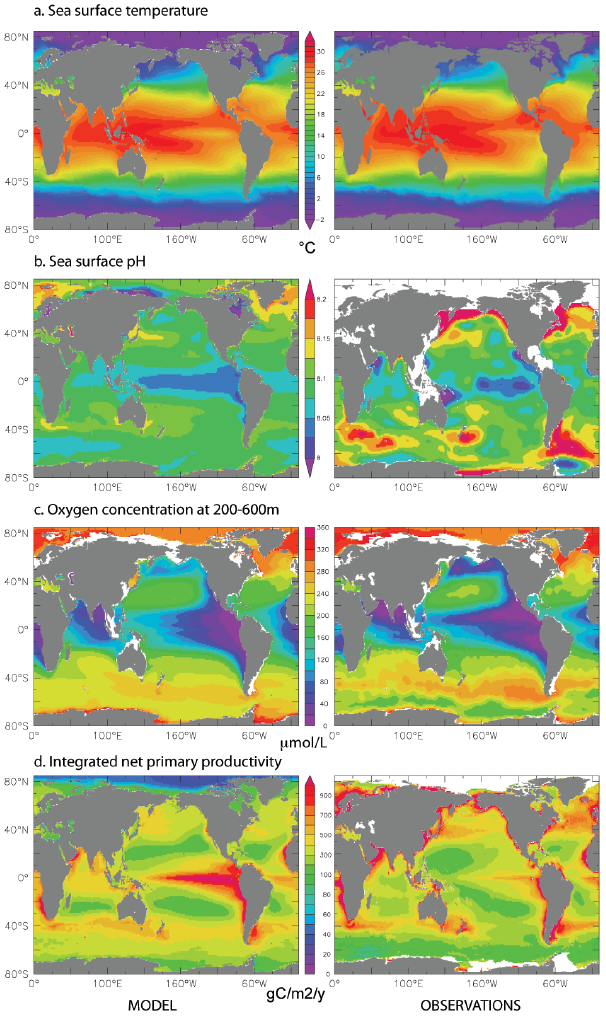
Fig. 1. Comparison of model-mean (a) SST ( ◦ C), (b) sur- face pH (pH unit), (c) subsurface O 2 averaged over 200–600m (mmolm − 3 ) , and (d) vertically integrated PP (gCm − 2 .y − 1 ) with data-based products. Observed estimates are from Reynolds et al. (2008) for SST, computed using DIC and alkalinity from Key et al. (2004) for surface pH, from WOA 2009 for O 2 , from Behren- feld et al. (1997) for NPP. All data are from 1990–1999 except observation-derived NPP from 1997–2006, and O 2 concentration from WOA 2009 climatology.